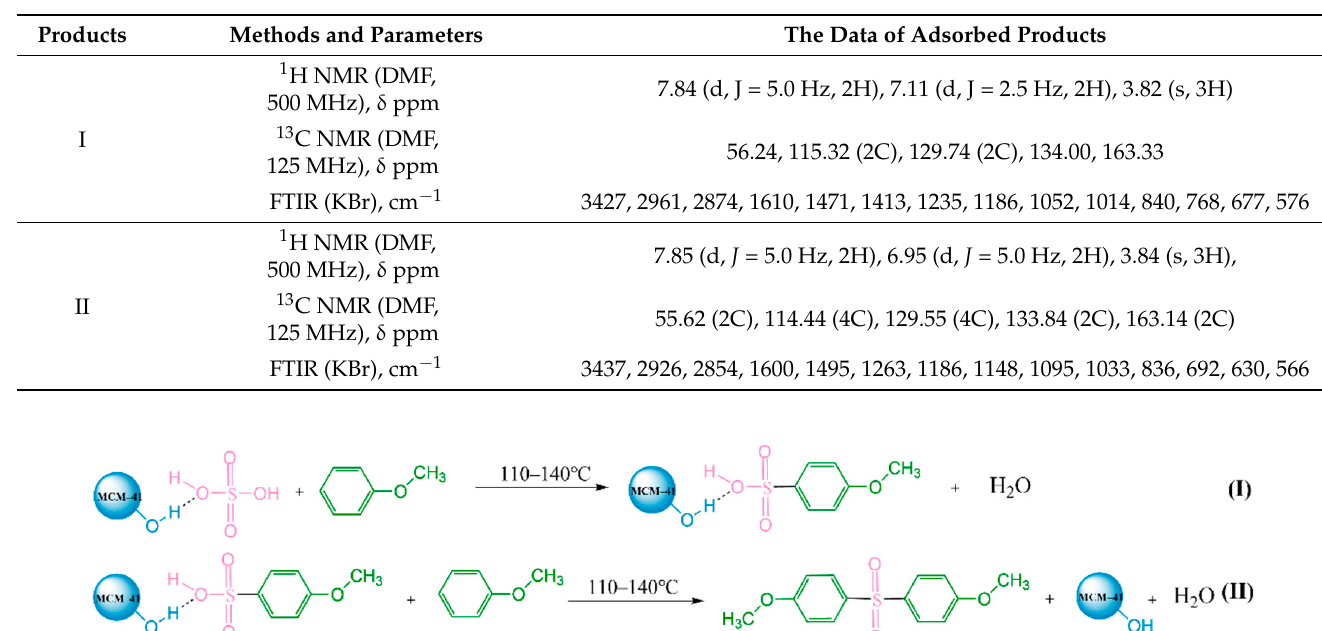
Table 3. Adsorption performance metrics of anisole under different conditions. Metrics